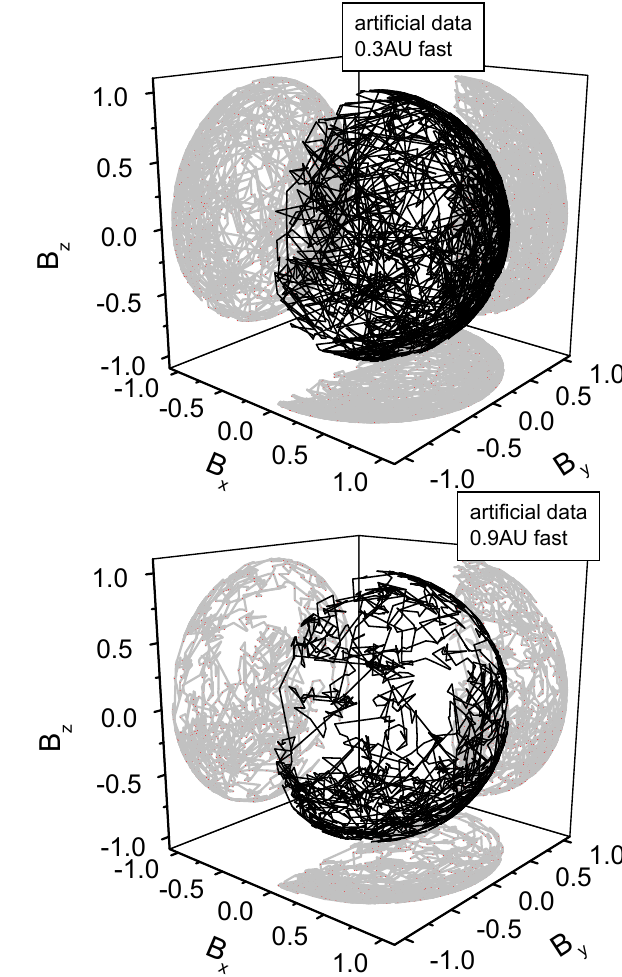
Fig. 12. Three-dimensional representation of vector displacements relative to artificial data generated by a random-walk, whose jumps obey a double-lognormal, whose parameters have been obtained by the best fit of real fluctuations. The top and bottom panels refer to fast wind at 0.9 and 0.3AU, respectively, and have to be compared to analogous plots for real data shown in Fig.